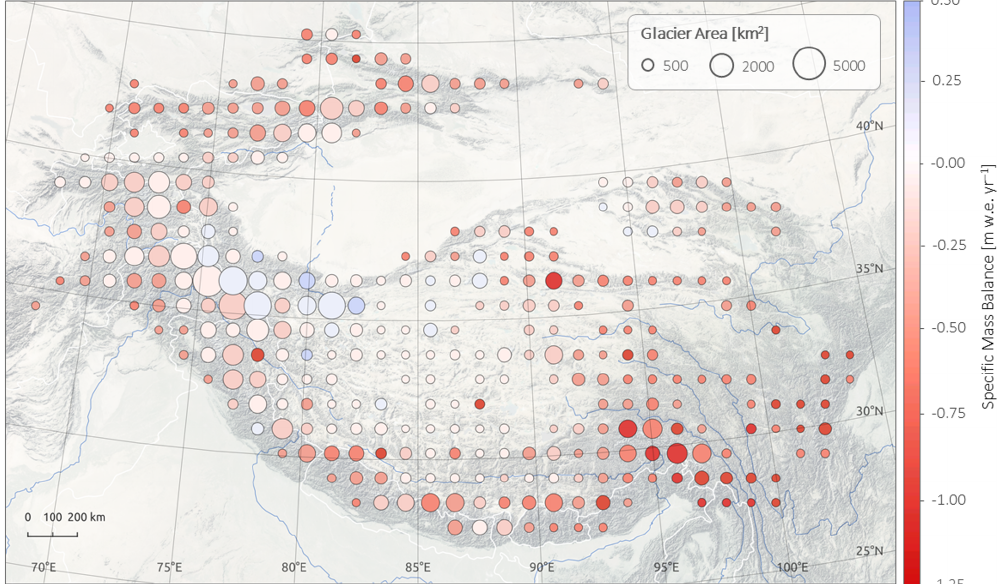
Figure 2. Specific glacier mass balance (mw.e.yr − 1 ) in High Mountain Asia (HMA) for the period of July 2010 to July 2019 on a 100 × 100km grid. The size of the circles is scaled by the total glacierized area within a 100 × 100km bin.